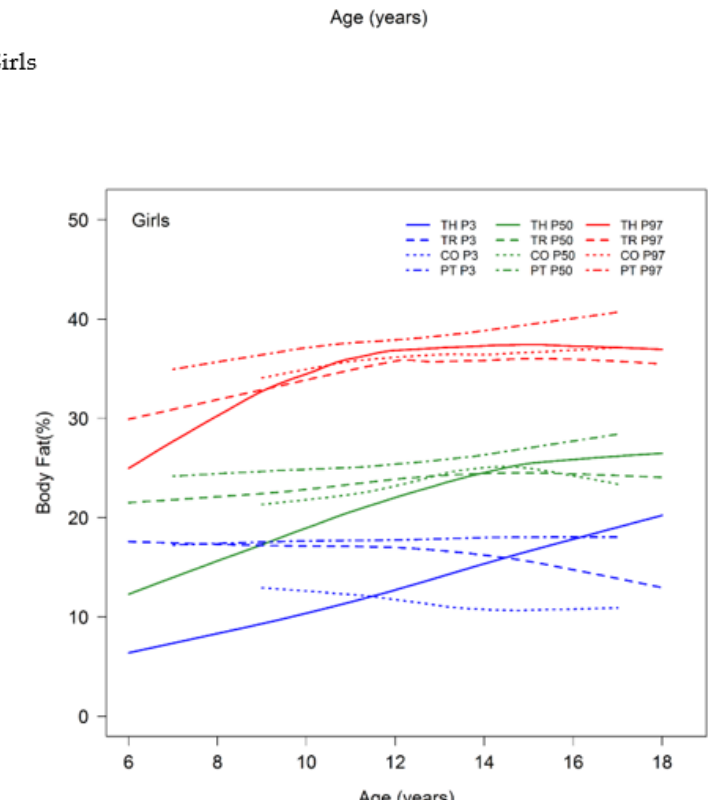
Figure 3. The 3rd, 50th and 97th percentiles for percentage body fat according to age in Thai, Turkish, Colombian and Portuguese ( a ) boys and ( b ) girls. Abbreviations: TH, Thai; TR, Turkish; CO, Colombian; PT, Portuguese.